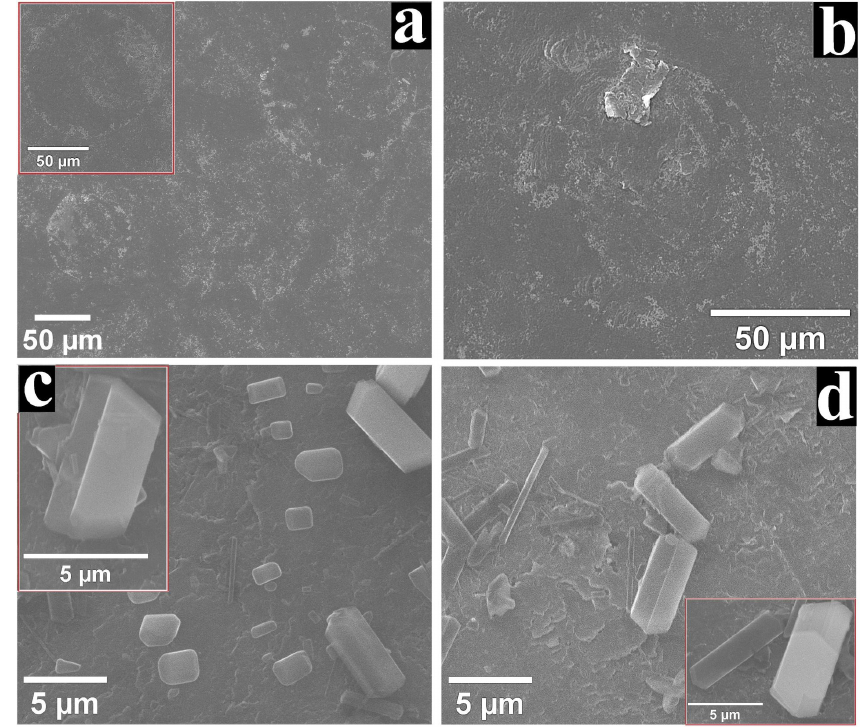
Figure 8. ( a ) SEM micrograph obtained on G CoP ‐ DMSO ‐ 1 before the electrochemical stability experi ‐ ment. Inset shows an aggregate identified on the specimen. ( b ) SEM image recorded on G CoP ‐ DMSO ‐ 1 after the test. ( c ) SEM micrograph obtained on G ZnP ‐ DMF ‐ 1 before the stability experiment. The inset presents an image at higher magnification. ( d ) SEM image recorded on G ZnP ‐ DMF ‐ 1 after the test. The inset shows an image at higher magnification.